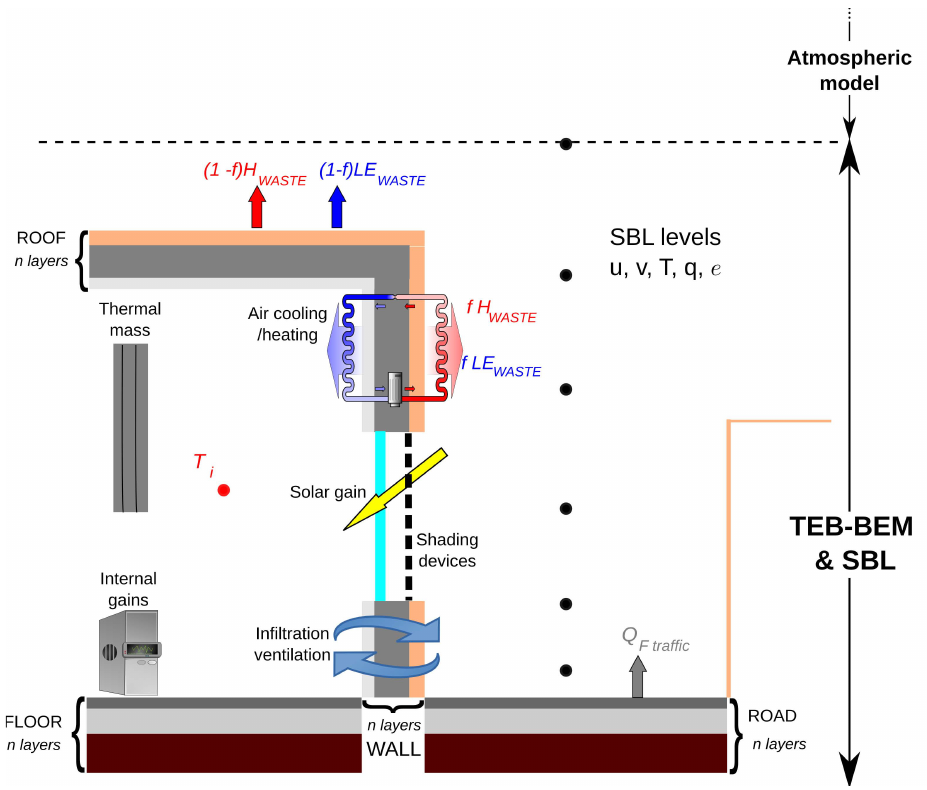
Fig. 1. Diagram of a building and an urban canyon. The main physical processes included in BEM-TEB are represented: heat storage in building and urban construction materials, internal heat gains, solar heat fluxes, waste heat from HVAC systems, etc. The diagram also represents the multi-layer version of the TEB scheme (Hamdi and Masson, 2008) and the possibility of coupling it with an atmospheric mesoscale